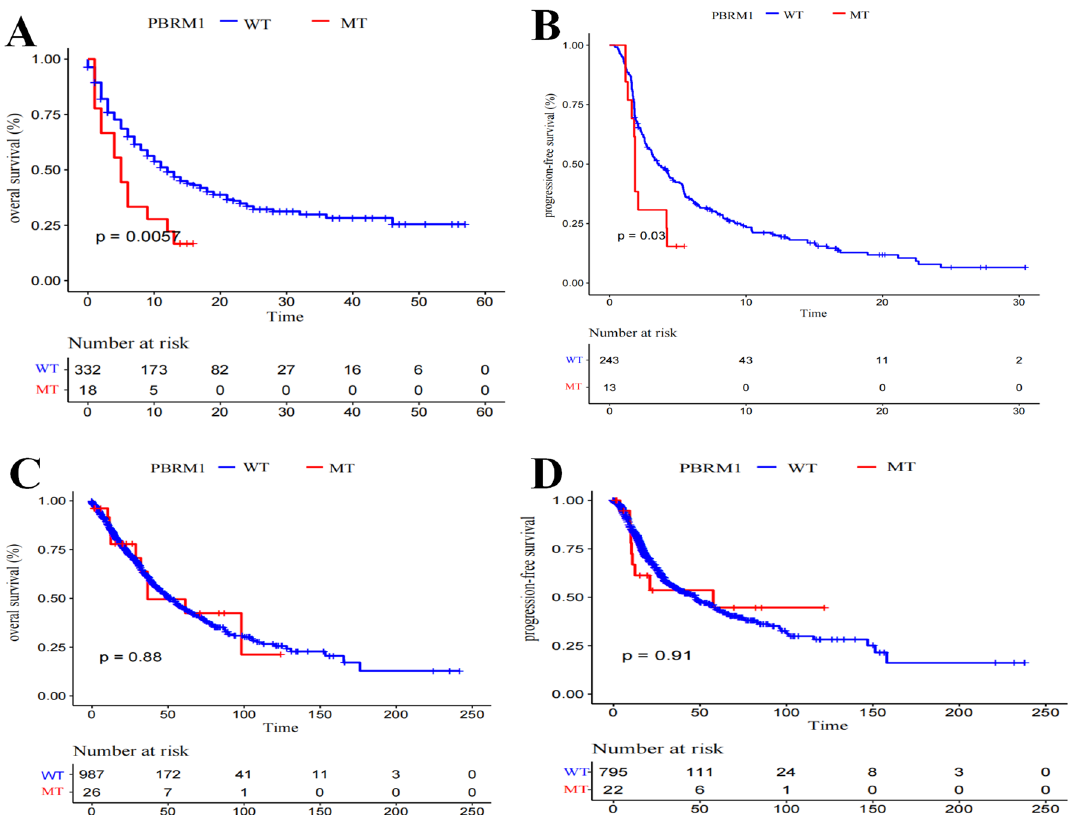
Figure 1. Survival analysis of NSCLC comparing patients with PBRM1 mutations and PBRM1 wild type. ( A ) Survival analysis of OS in patients with ICB-treated NSCLC. ( B ) Survival analysis of PFS in patients with ICB-treated NSCLC. ( C ) Survival analysis of OS in patients with NSCLC from the TCGA cohort. ( D ) Survival analysis of PFS in patients with NSCLC from the TCGA